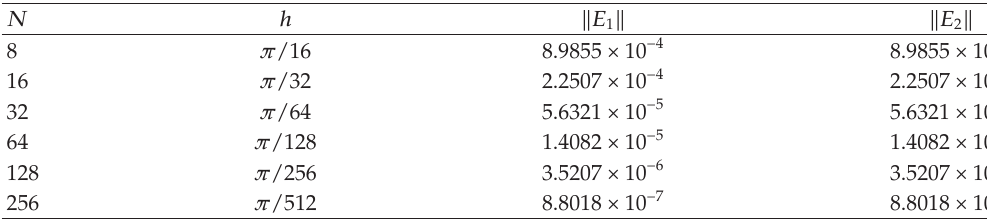
Table 3: Results for Example